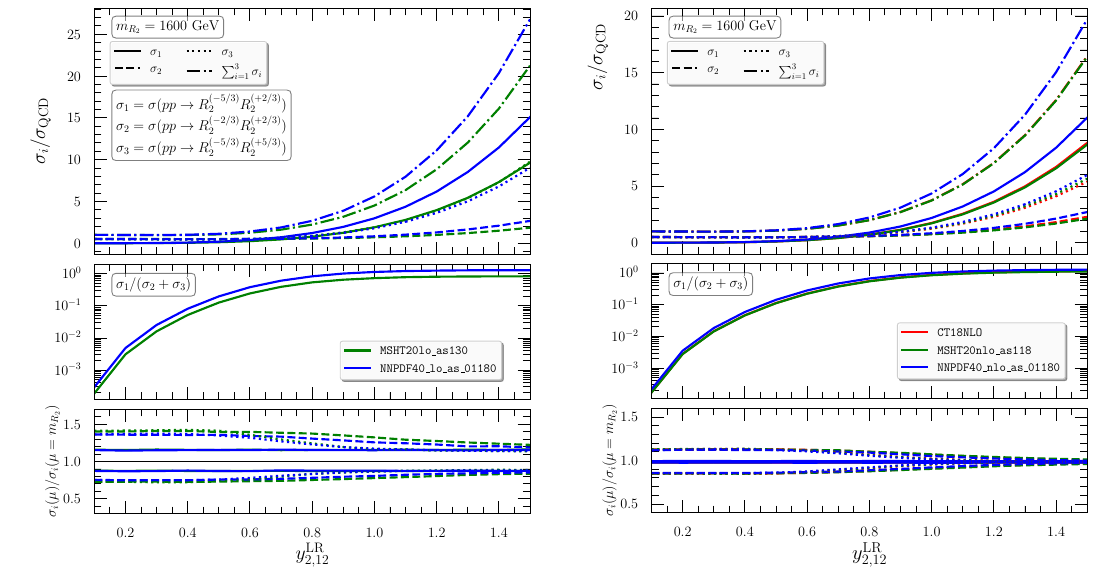
Figure 5 . Upper panels : ratios of various R 2 leptoquark pair production cross sections of (3.1) to the QCD-driven cross section (3.2). Predictions are presented as a function of y LR both at LO (left) and NLO (right). Middle panels : ratio of the off-diagonal leptoquark pair production cross section σ 1 to the total diagonal pair production cross section σ 2 + σ 3 . Lower panels : dependence of σ i (for i = 1 , 2 , 3 ) on the renormalisation and factorisation scales when they are varied simultaneously by a factor of 2 up and